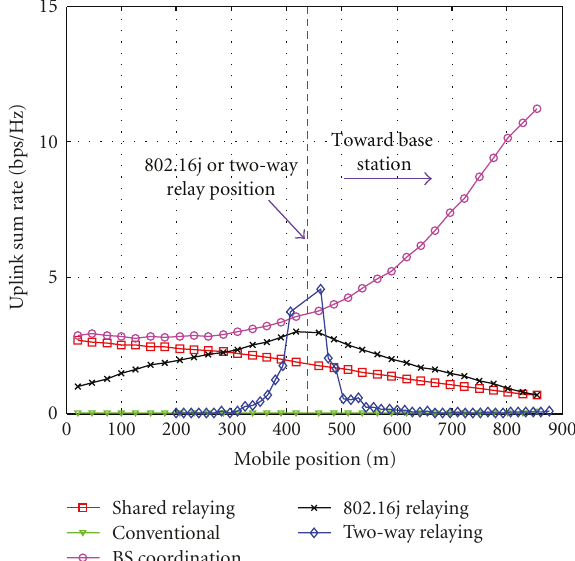
Figure 11: Uplink sum rate of two-way relaying and other strategies versus MS position relative to cell edge. The relay station is located 440m from the base station.